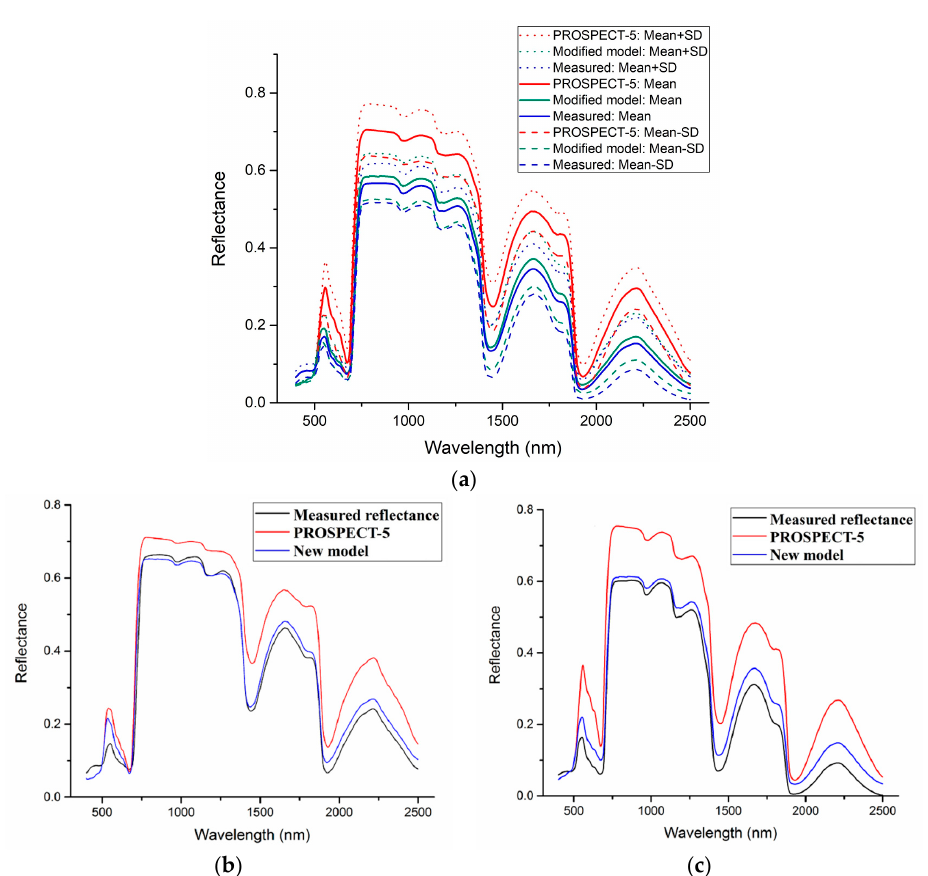
Figure 7. The simulated spectra (PROSPECT-5 and the new model) and measured spectra: ( a ) The mean (±standard deviation, SD) of simulated spectra and measured spectra of the 11 samples; ( b ) The selected representative sample : No. 5 sample (wheat: C ab = 49.63 μ g/cm 2 ; C car = 8.94 μ g/cm 2 ; C w = 0.0096 cm; C m = 0.0061 g/cm 2 ; C cu = 0.0557 μ g/cm 2 ); ( c ) The selected representative sample: No. 7 sample (pak choi: C ab = 27.61 μ g/cm 2 ; C car = 19.32 μ g/cm 2 ; C w = 0.0320 cm; C m = 0.0031 g/cm 2 ; C cu = 0.1520 μ g/cm 2 ).